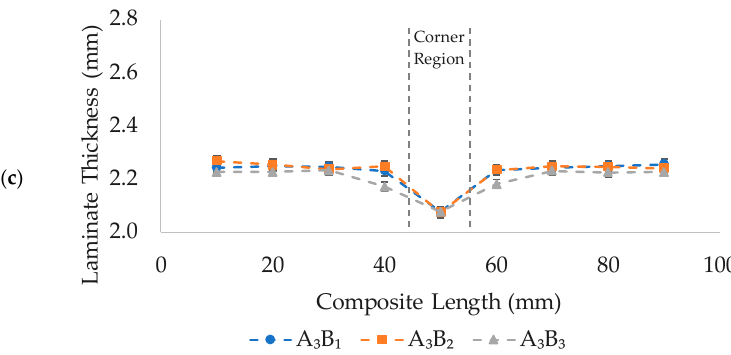
Figure 8. Thickness across the length of laminates with concave corner produced using ( a ) SVB, ( b ) MSVB, and ( c ) DVB techniques.